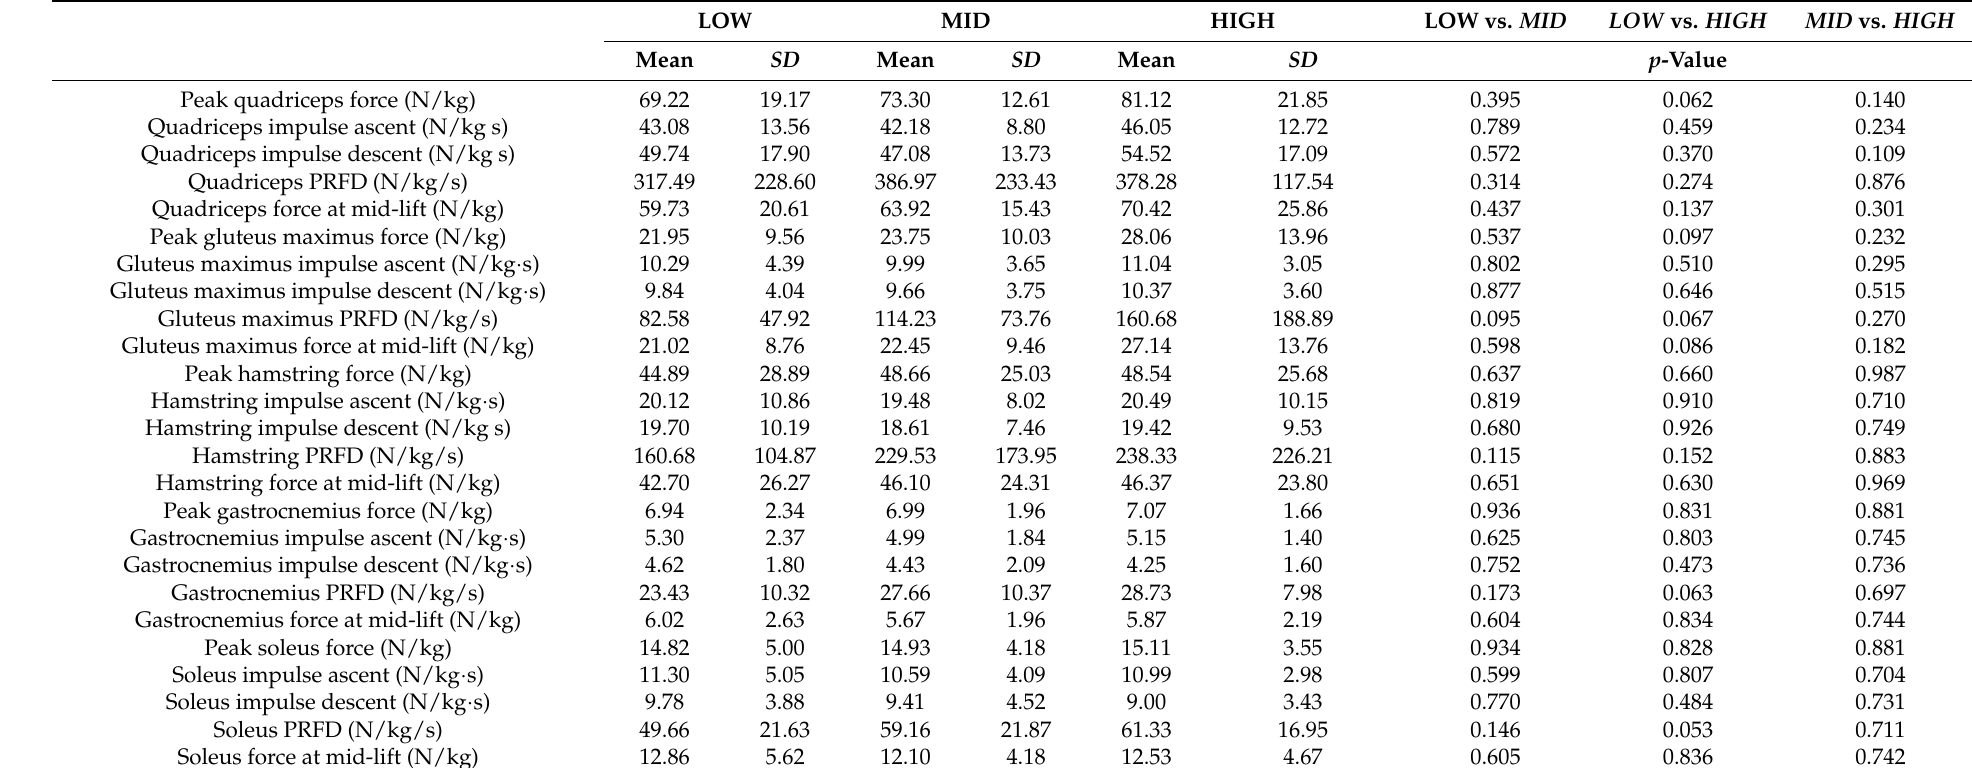
Table 2. Muscle forces (mean ± SD) and statistical comparisons as a function of each experimental group. LOW MID HIGH LOW vs. MID LOW vs.